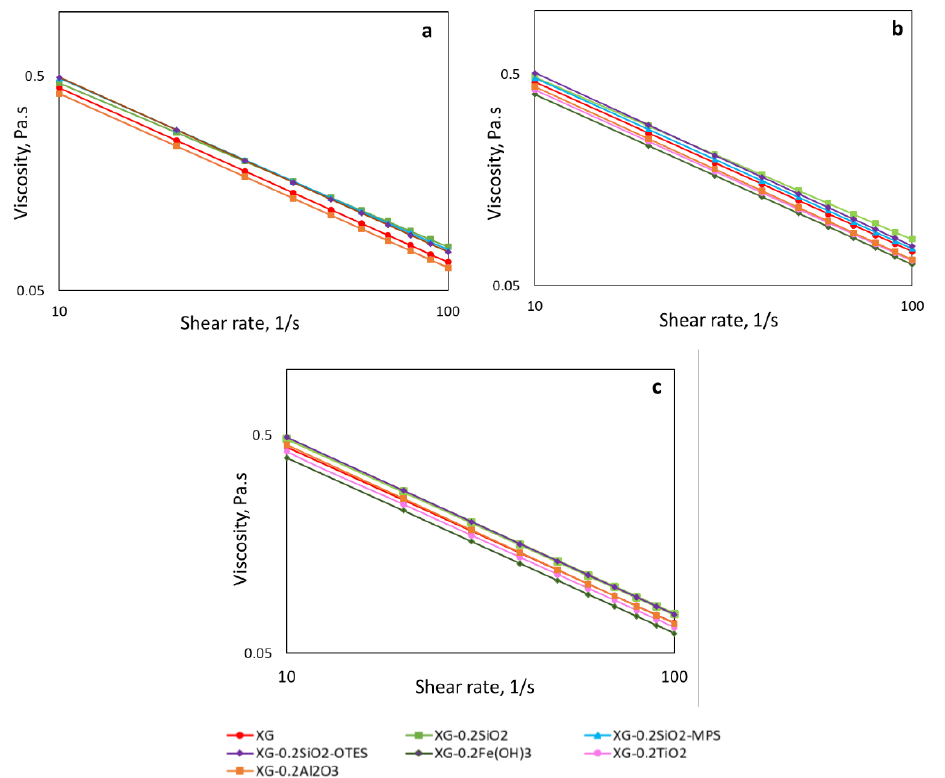
Figure 3. Viscosity of 4000 ppm XG solutions with 1000 ppm SDS and SiO 2 , SiO 2 -MPS, SiO 2 -OTES, Al 2 O 3 , TiO 2 , and Fe(OH) 3 at a ) 0 wt %, ( b ) 0.3 wt %, and ( c ) 1.0 wt % NaCl concentration at 25 °C.